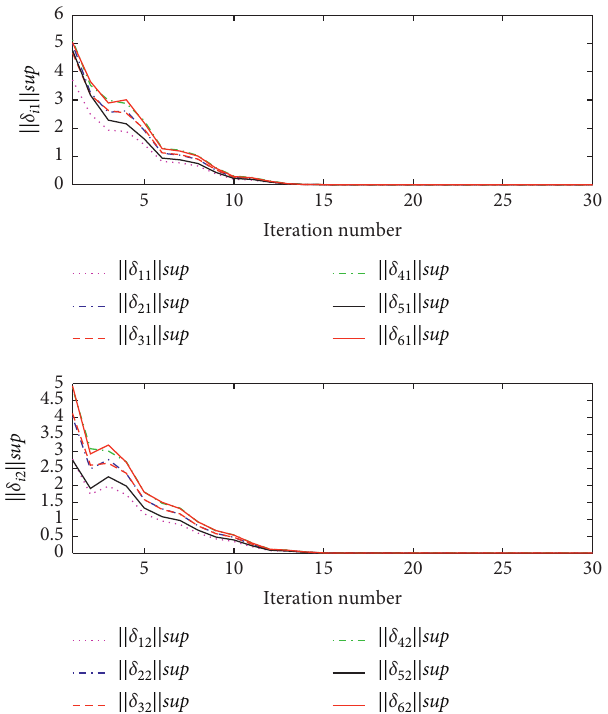
Figure 3: Consensus errors of six followers for Case